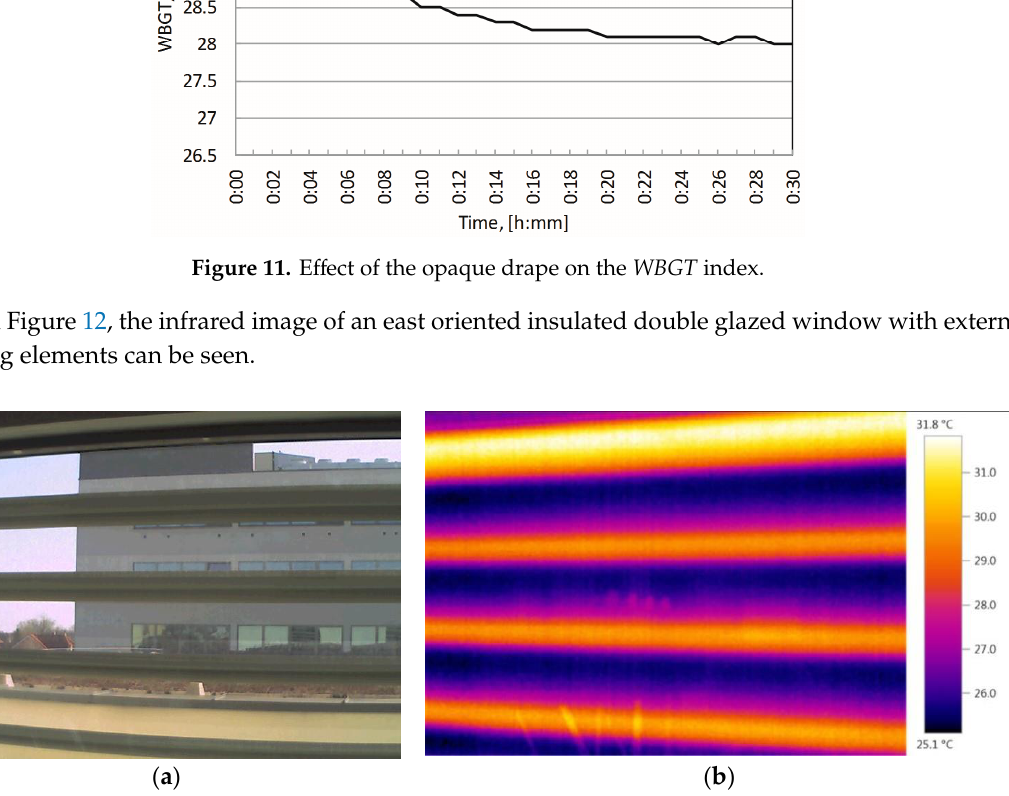
Figure 12. ( a ) Normal and ( b ) infrared photo of the window in east oriented shaded double glazed insulated window.